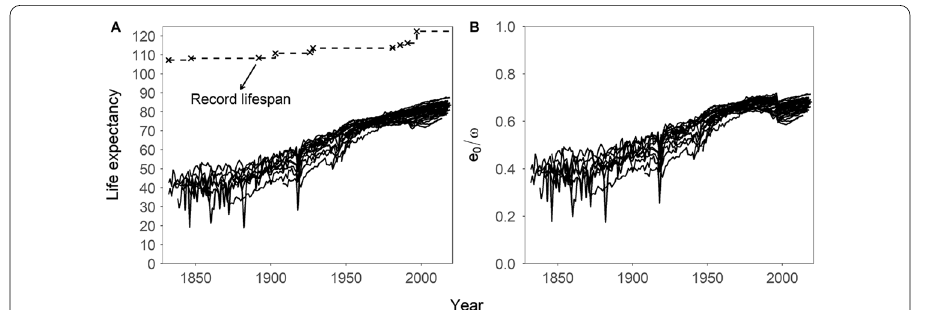
Fig. 3 Trends of female life expectancy and record lifespan ( A ) and ratio between the two quantities ( B ), 1832–2020, HMD countries (Source: Authors’ elaboration based on the HMD